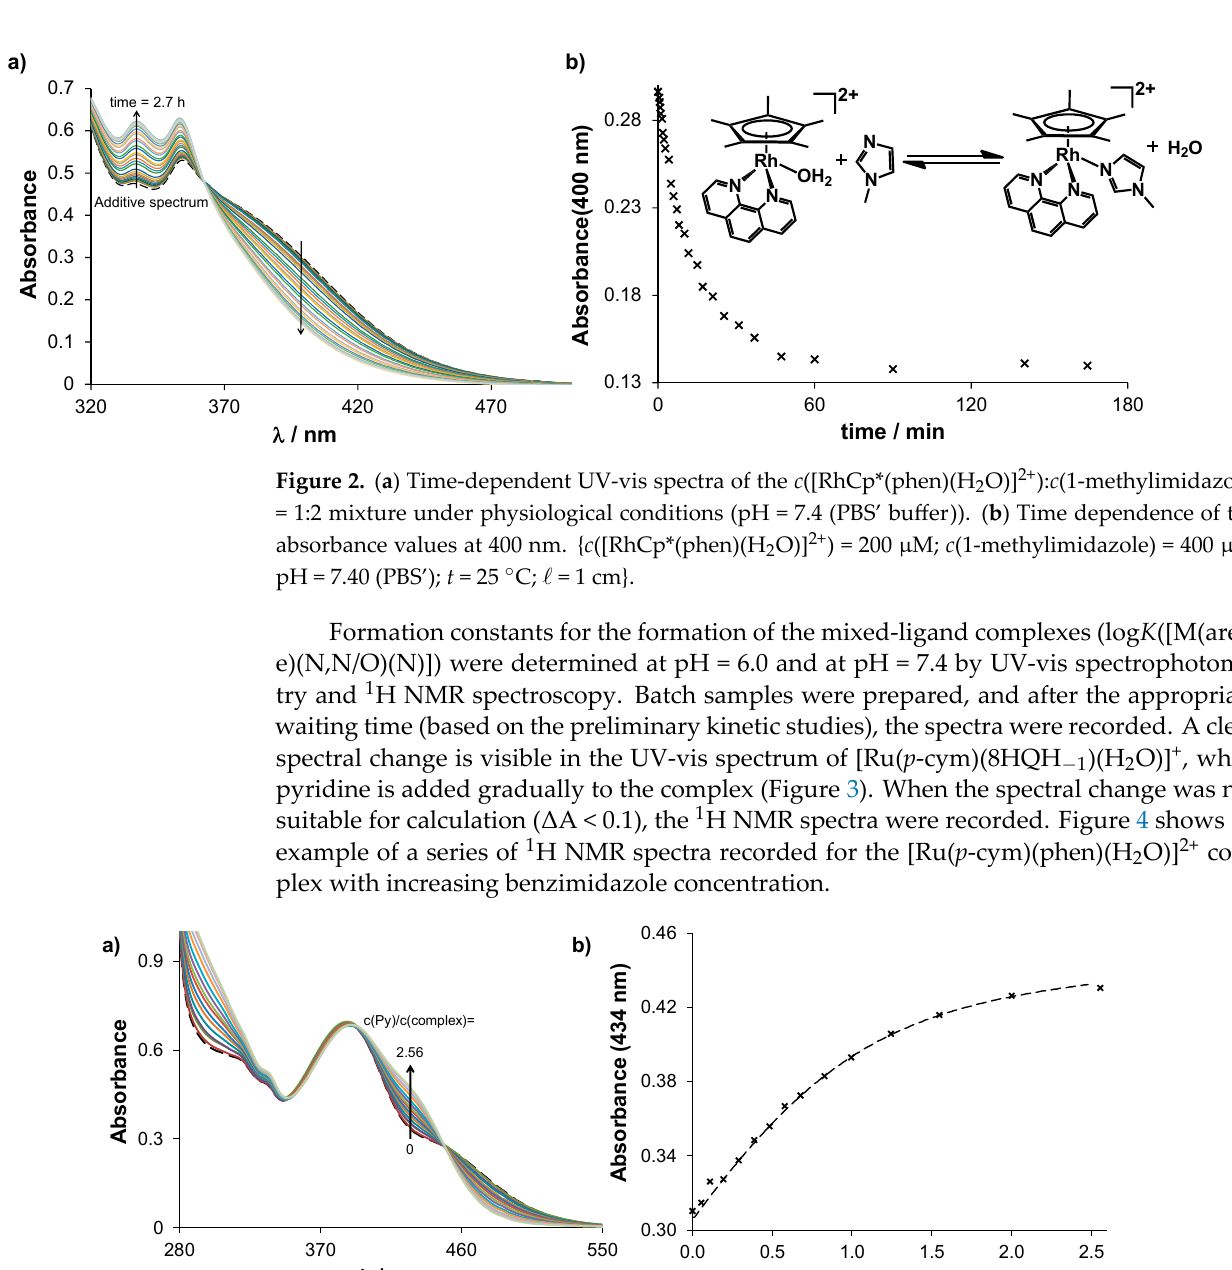
Figure 3. ( a ) UV ‐ vis spectra of c ([Ru( p ‐ cym)(8HQH ‐ 1 )(H 2 O)] + ) at various pyridine concentrations at pH = 5.95 (PBS’ buffer)). ( b ) Absorbance values at 434 nm as the function of c (Py)/ c (aqua complex)